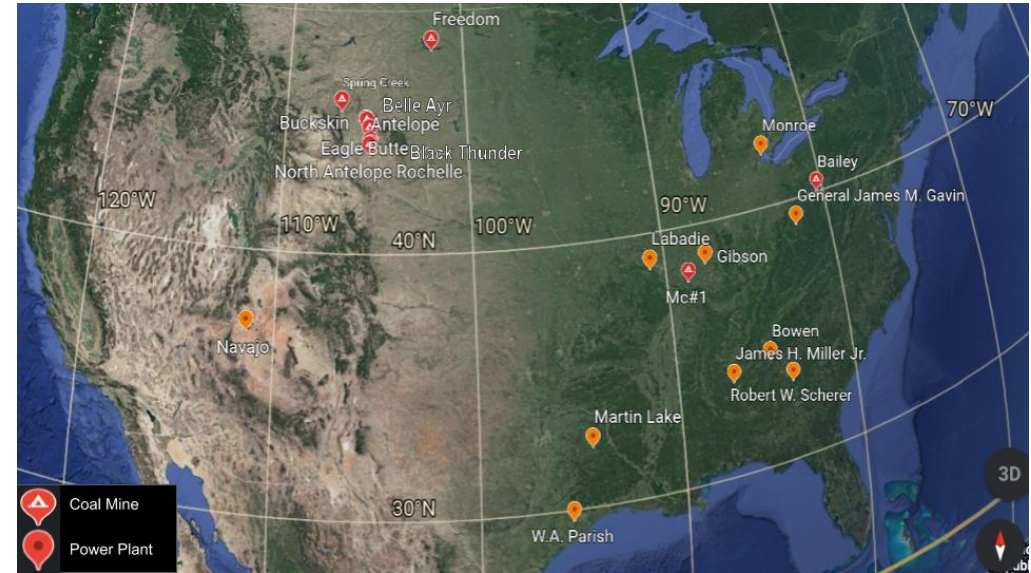
Figure 12. Map of Top CO 2 Emission Bottlenecks- Coal Extraction and Power Plants in the United States (Generating using Google Earth).